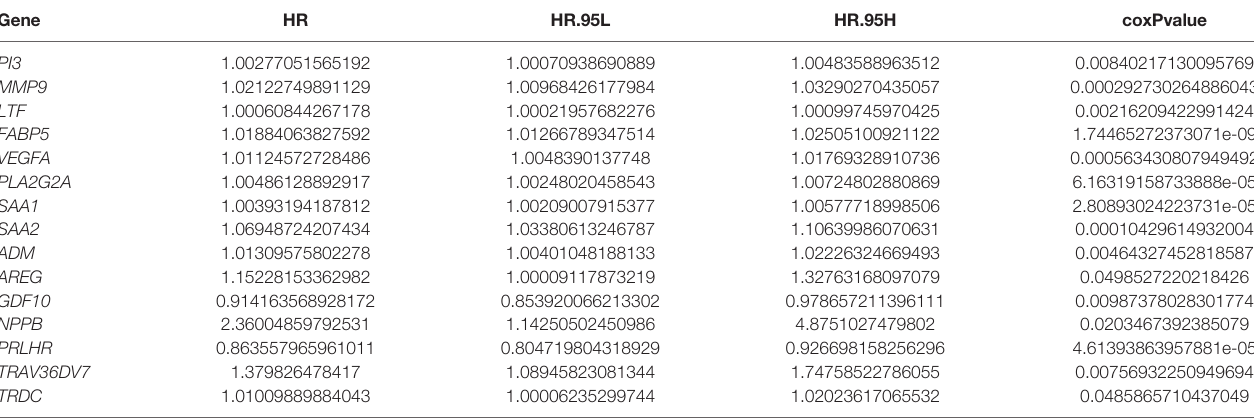
TABLE 3 | Univariate Cox analysis of 15 differentially expressed immune-related genes. Gene